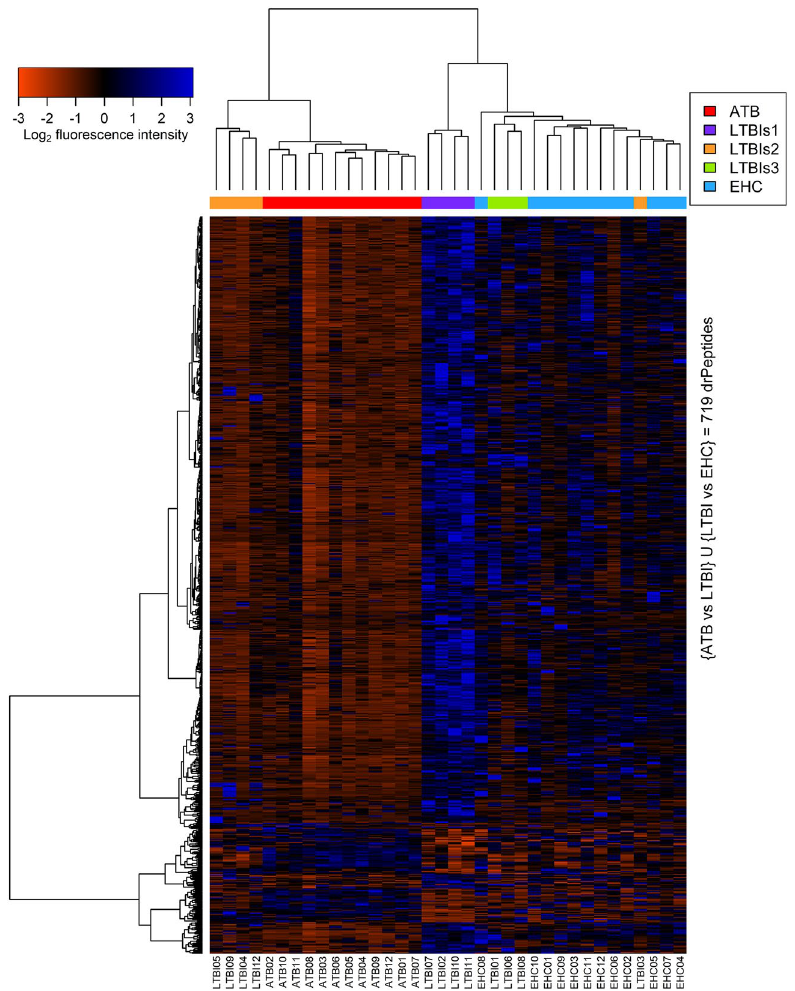
Figure 2. Heatmap and cluster analysis of IgA reactivity against 719 non-redundant drPeptides. IgA signals specific to 719 non-redundant peptides (horizontal axis), which had been identified from ATB v. LTBI (n = 715) and LTBI v. EHC (n = 8), are visualized across all 36 samples (vertical axis). The heatmap was generated using gplots package (heatmap.2) in the R/Bioconductor environment (https:// cran.r- proje ct. org/ packa ge= gplots). The level of IgA responses was represented by z-score of log 2 normalised fluorescence intensity, in which 0 indicates the mean across 36 samples (black); positive (blue) and negative (red) values indicate standard deviation above and below the mean,